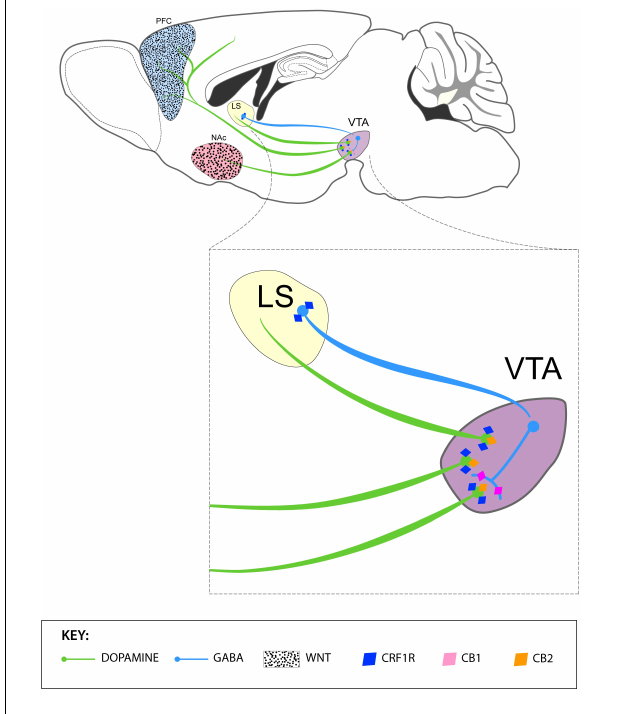
FIGURE 2 | Summary of the contributions by Latin American-based neuroscientist in the neurobiology of stress and addiction. The upper panel depicts VTA DA projections to the PFC and NAc and the modulatory role of GABAergic neurons of the lateral septum (LS) and VTA in the function of DA neurons. Activation of GABAergic neurons of the LS inactivates VTA GABA interneurons and, in turn, disinhibits DA neurons in the VTA. The PFC and NAc express WNT proteins, which play a crucial in the development and expression of cocaine sensitization in rats (black dots). The lower panel represents the expression of (i) CRF1 receptors by GABAergic neurons of the LS and DA neurons of the VTA, (ii) CB1 receptors GABAergic interneurons of the VTA and (iii) CB2 receptors in DA neurons of the